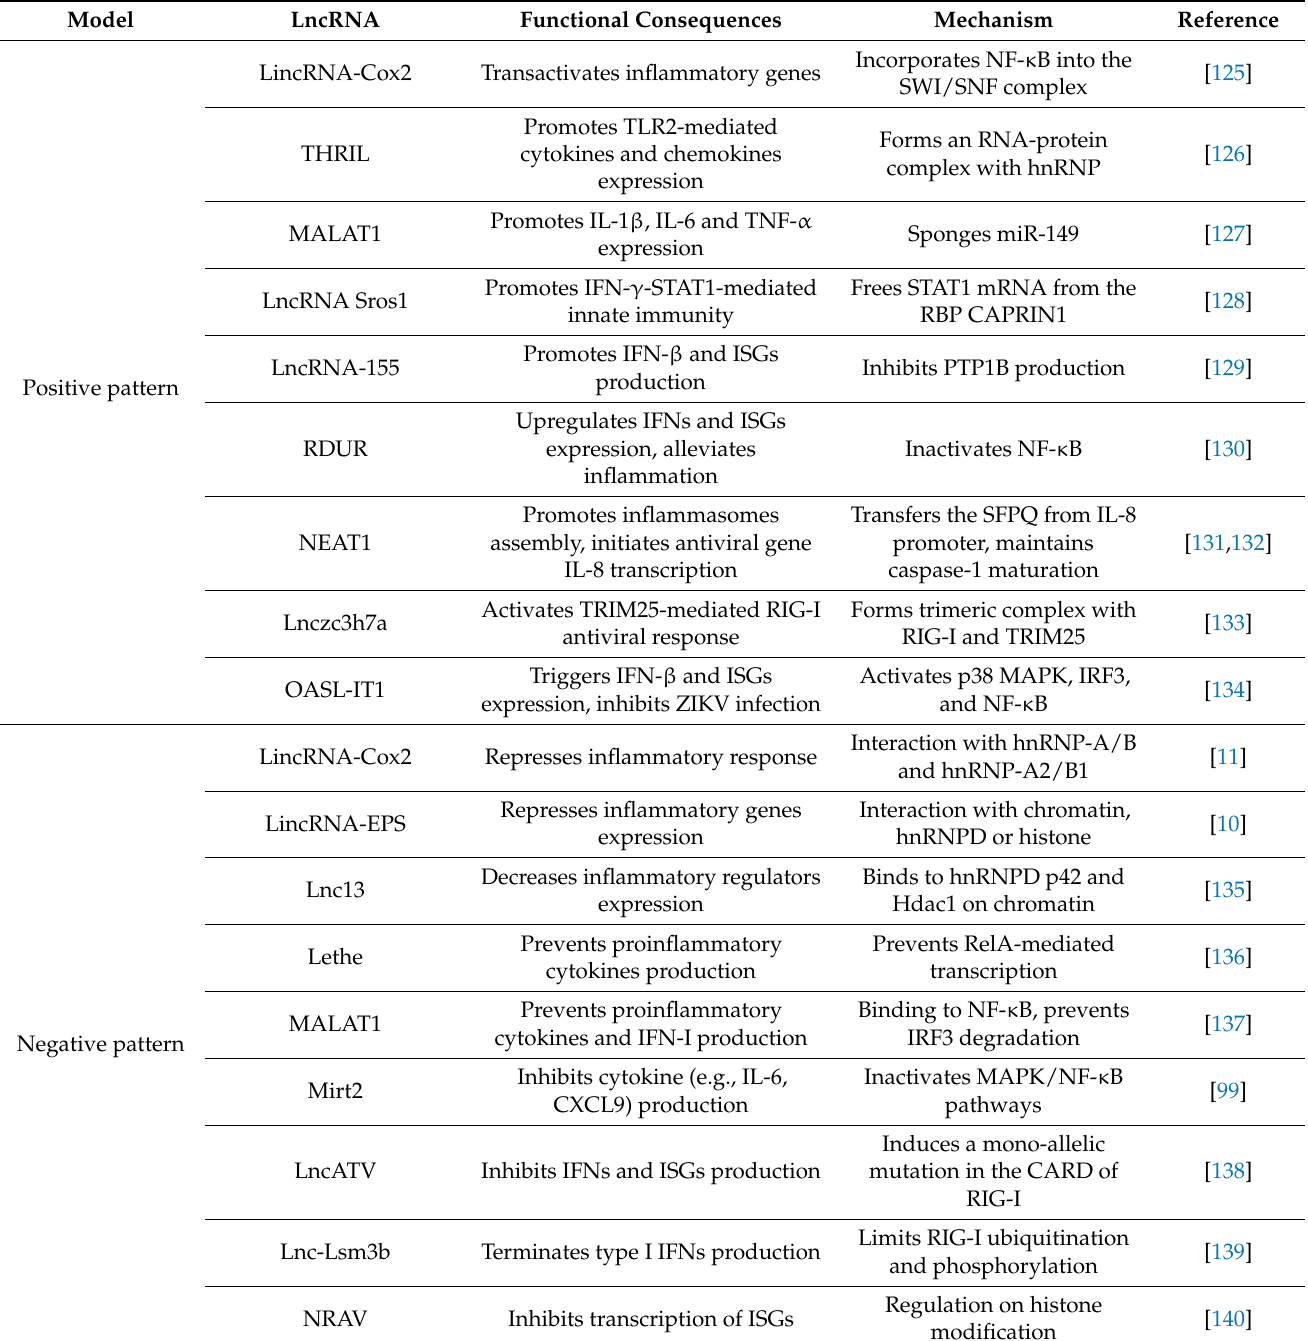
Table 2. Long non-coding RNAs act as modulators of inflammatory responses in innate